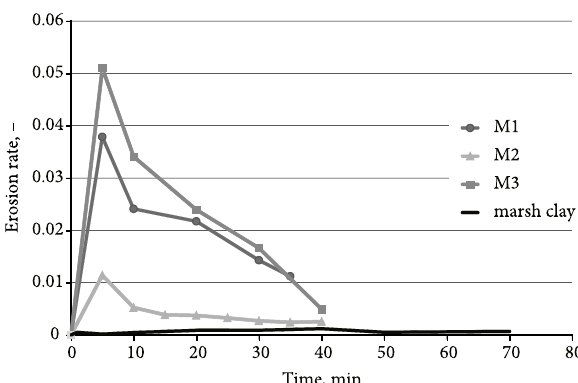
Fig. 14. Erosion rates of dredged material and marsh clay (modified after Lesch